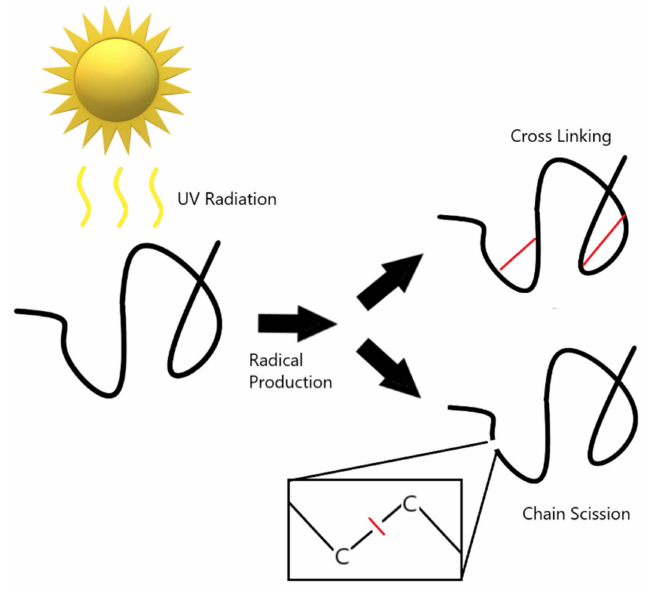
Figure 2. Polymer autooxidation by UV